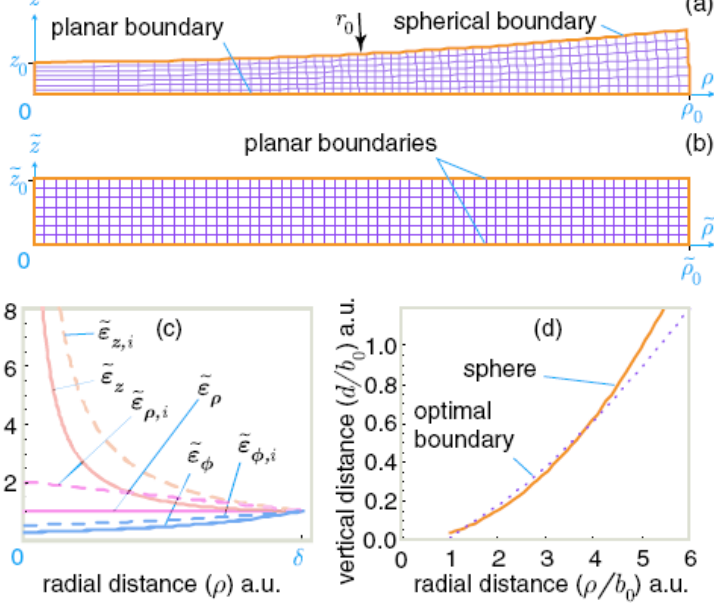
Figure 1. A space between a spherical surface and a planar surface (a) mapped onto a layer with planar boundaries ( b ). ( c ) Distribution of the radial (top), azimuthal (middle), and axial (or vertical) diagonal components of permittivity and permeability in the equivalent planar waveguide. Dashed lines show the same components in the waveguide with a radius-dependent refractive index. ( d ) Normalized profile of the optimal waveguide = 172 µm. The shape of the optimal waveguide may shape plotted for a cloak radius of b 0 be approximated by a spherical surface placed on top of a flat surface, as shown by the dashed